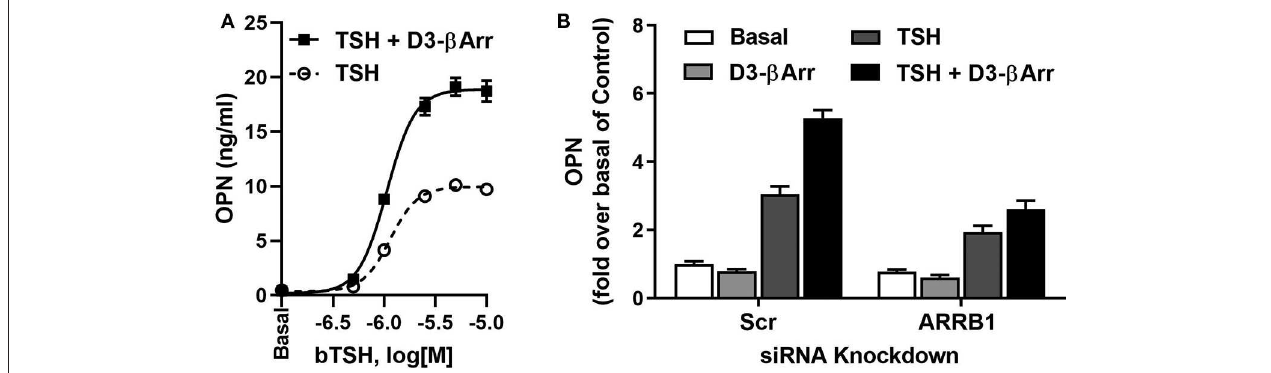
FIGURE 2 | D3- β Arr is a functionally selective TSHR agonist. (A) D3- β Arr is a positive allosteric modulator for TSH-induced OPN secretion. U2OS-TSHR cells were treated with increasing doses of TSH with or without 5 µ M D3- β Arr in EMEM with 0.1% BSA for 7 days prior to OPN measurement by ELISA in cell culture media (43). (B) The potentiating effect of D3- β Arr is mediated by β -arrestin 1 in U2OS-TSHR cells. Cells were transfected with non-targeting (Scr) or β -arrestin 1 (ARRB1) siRNA, respectively. After 72h of siRNA-mediated knockdown, cells were treated with 10 µ M D3- β Arr, 2 µ M TSH or their combination in EMEM with 0.1% BSA for 5 days. OPN secretion was measured in conditioned media by ELISA ( 43).